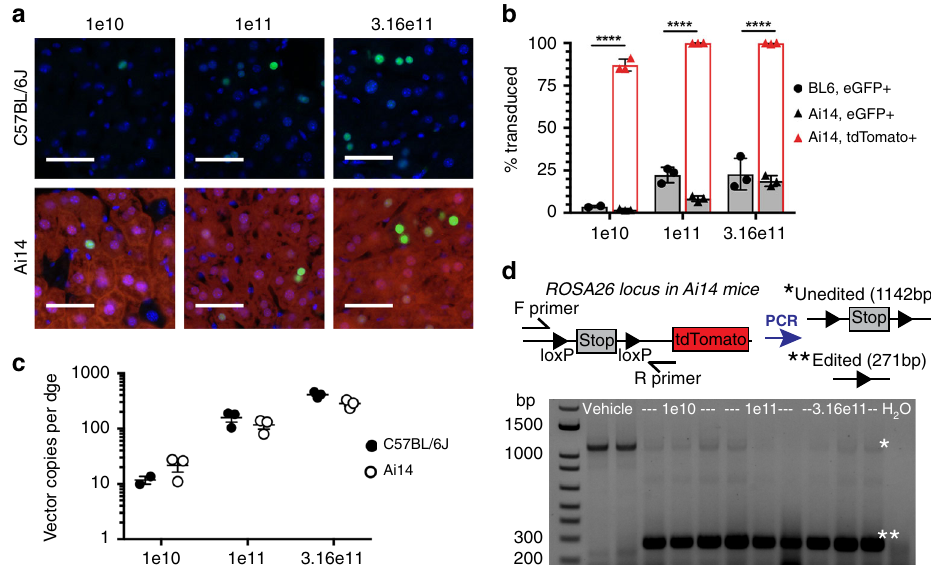
Fig. 2 Ai14 mice improve the sensitivity for liver AAV transduction. a Representative photomicrographs of liver sections harvested from AAV8-Cre-eGFP treated C57BL/6J or Ai14 mice 2 weeks post IV delivery at the indicated doses (total vector genomes per mouse). eGFP (green) and tdTomato expression (red) and nuclei (blue) are evident. n = 2 – 3 for C57BL/6J mice, n = 3 for Ai14 mice. Scale bars = 50 µ m. b Quanti fi cation of hepatocyte transduction in C57BL/6J and Ai14 at the indicated doses. Values for individual mice are shown along with the mean and standard deviation for each strain and dose group. Data were analyzed by two way-ANOVA followed by Bonferroni post hoc comparing % transduced cells per animal in BL6 (%eGFP + ) versus Ai14 (%tdTomato + ) mice, **** p <0.0001. c Comparison of AAV vector copies per diploid genome equivalent (dge) in liver samples. Values for individual mice are shown along with the mean and standard error for each strain and dose group. d Cre-mediated recombination in Ai14 mice at the ROSA26 locus as detected by PCR assay of liver genomic DNA. Source data are provided as a Source Data fi